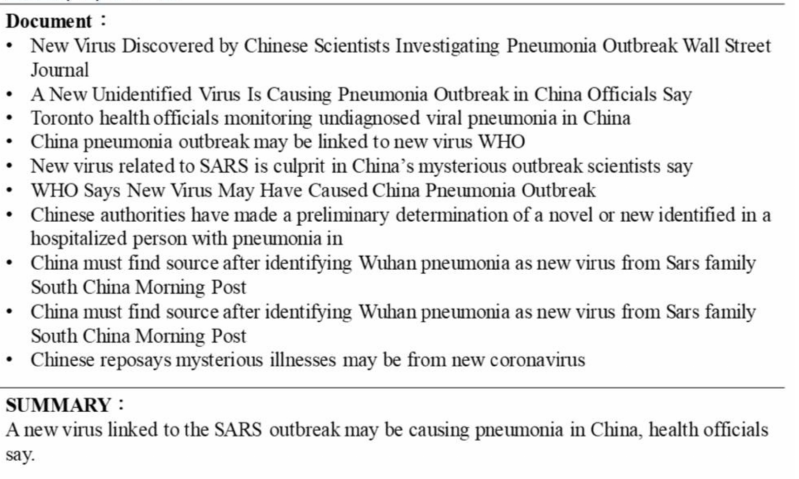
Figure 7. A sample resulting summary of formulated event topics (9 January 2020).